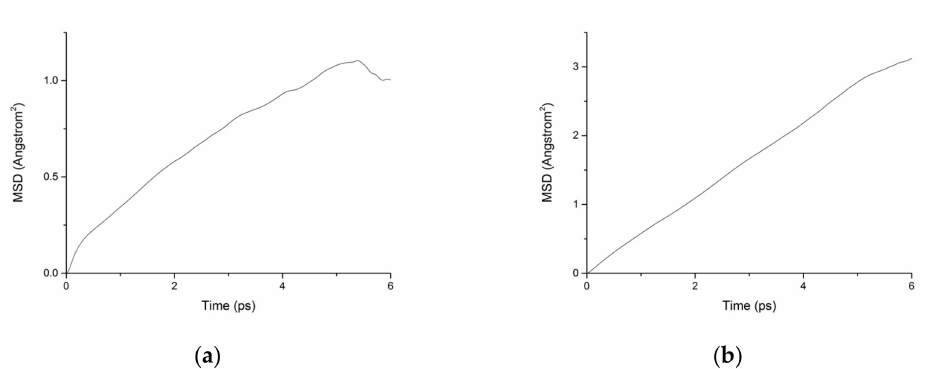
Figure 11. MSD diagram of chloride ions in C-S-H nanopores without fatigue loading. ( a ) Pore diameter: 1.5 nm. ( b ) Pore diameter: 3 nm.